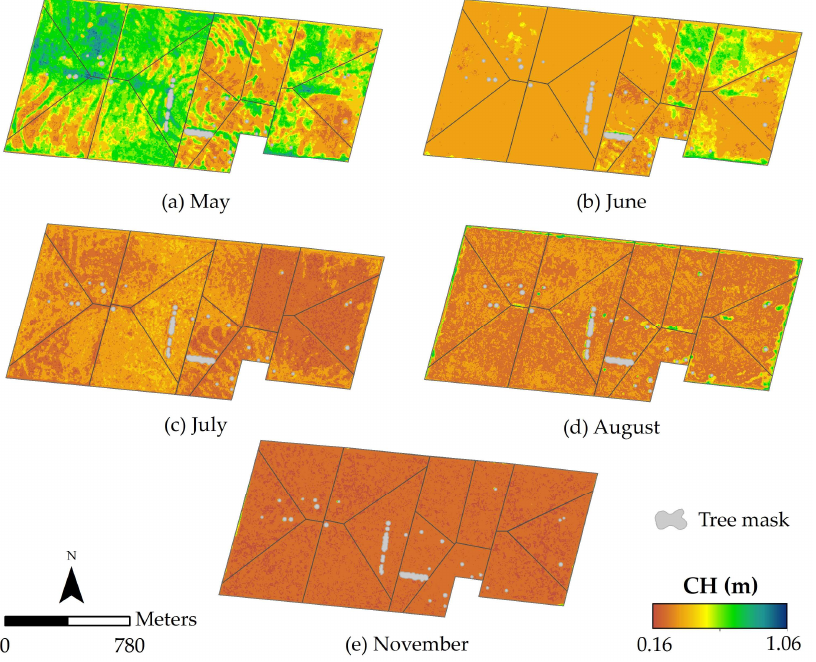
Figure 8. Pasture canopy height (CH) spatial maps predicted by the best extreme gradient boosting (XGBoost) model for the study area in the months of May ( a ), June ( b ), July ( c ), August ( d ), and November ( e ).